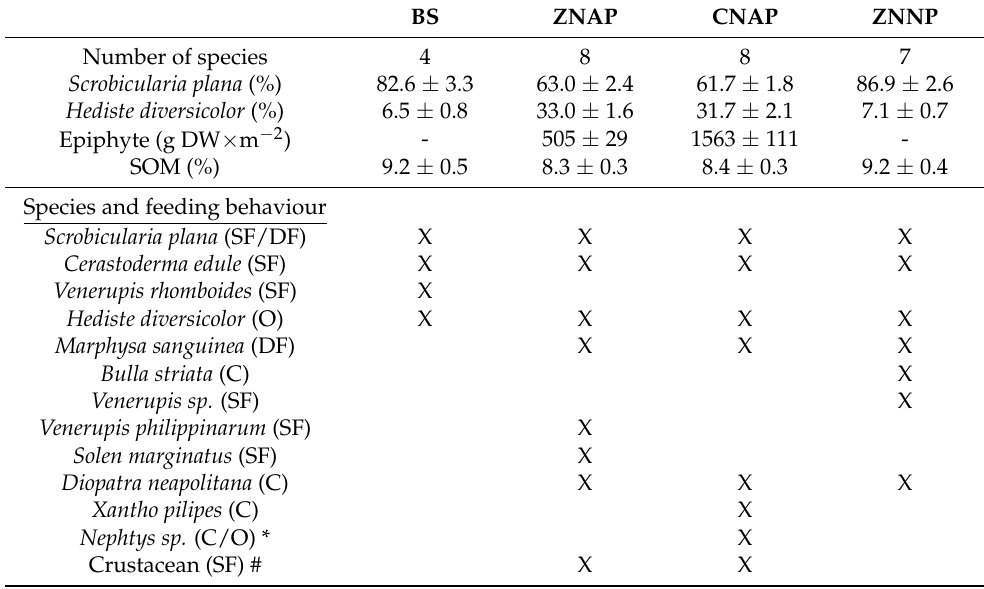
Table 2. Effect of artificial patches on species feeding behavior and richness, percentage of Scrobicularia plana and Hediste diversicolor , epiphyte production, and sediment organic matter (SOM). BS, bare sediment; ZNAP, artificial patches of Zostera noltei ; CNAP, artificial patches of Cymodocea nodosa ; ZNNP, natural patches of Z. noltei . SF, suspension feeder; DF, deposit feeder; O, omnivore; C, carnivore. X, indicates species presence in the treatment. *, feeding behavior depends on species level. #, not determined. Data are expressed as mean ± SE.